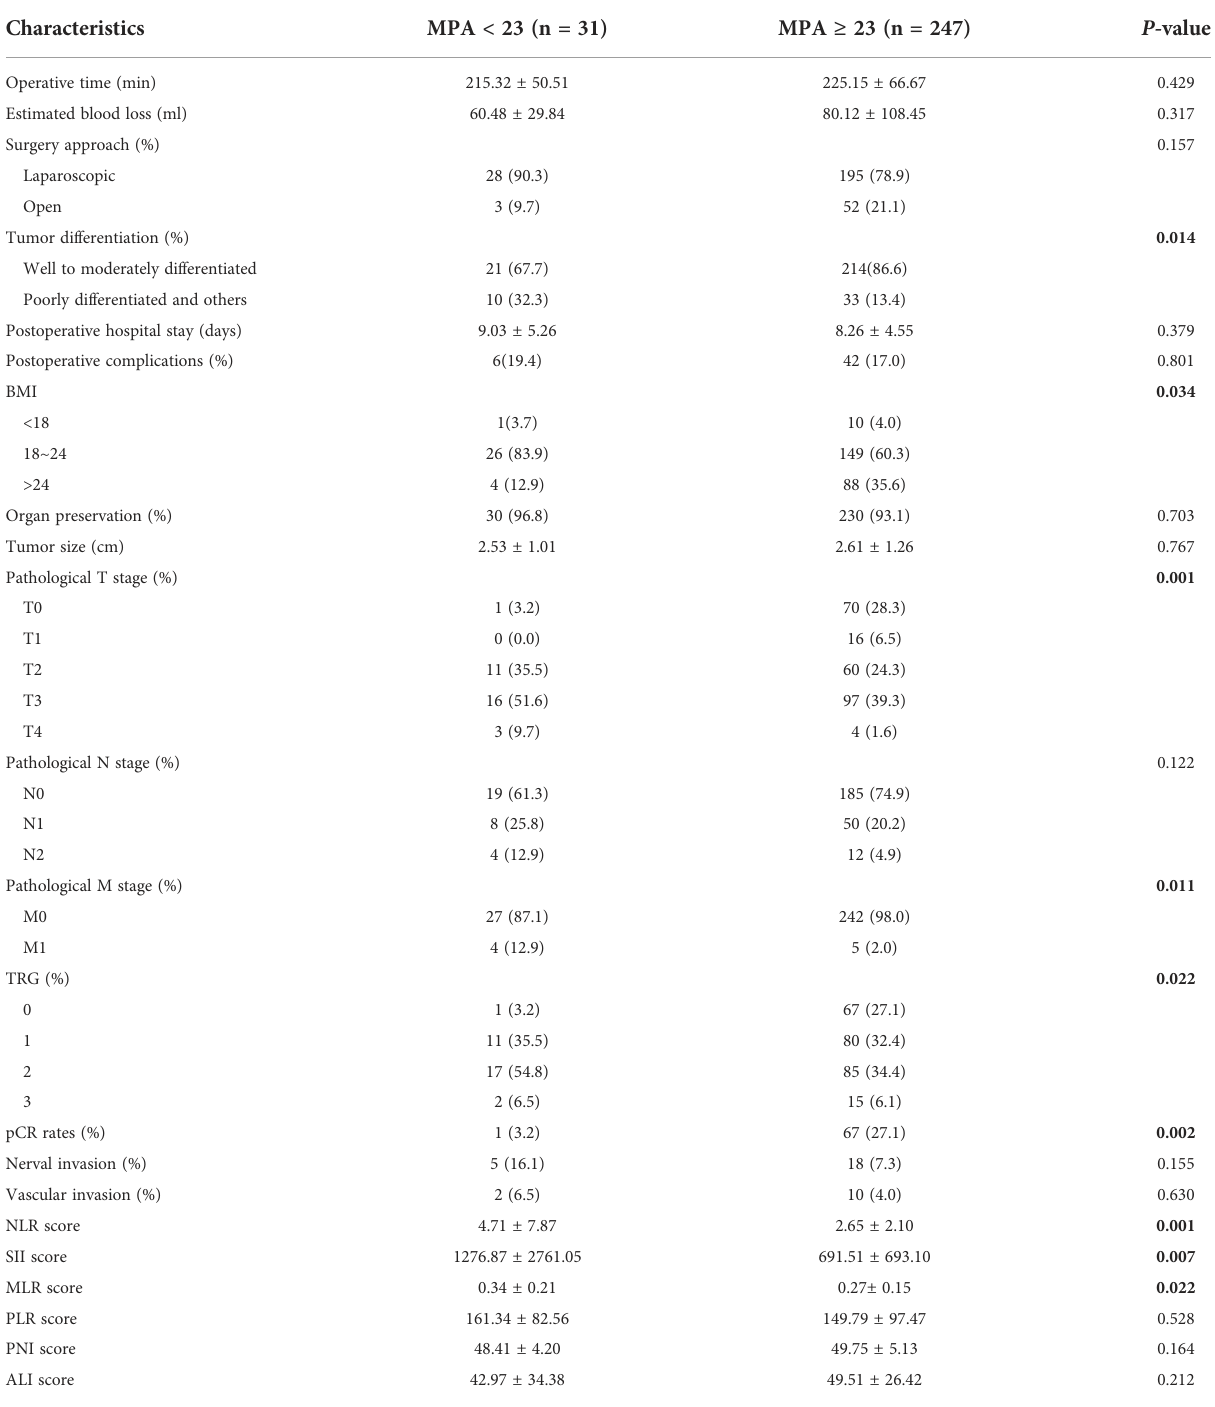
TABLE 2 Operative and postoperative outcomes in patients with LARC after NCRT strati fi ed by MPA.